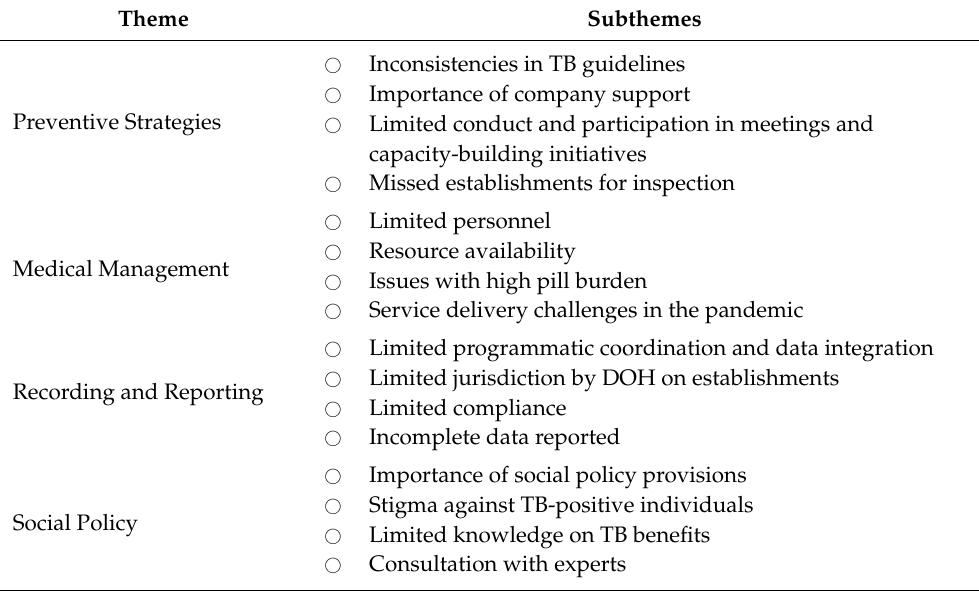
Table 2. Summary of themes and